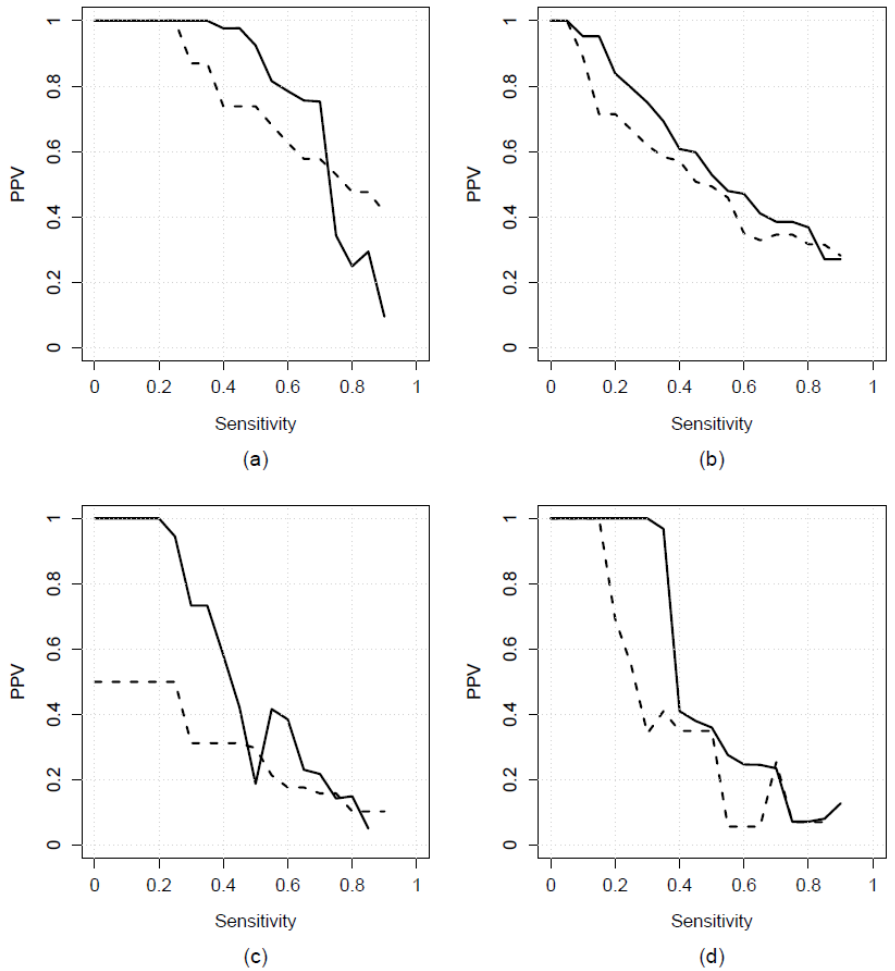
Figure 3. Validation positive predictive value (PPV) at various sensitivity thresholds for the optimal state-wide (solid) and metropolitan (dashed) models for: ( a ) high risk foot (HRF), ( b ) chronic obstructive pulmonary disease (COPD), ( c ) heart failure (HF), and ( d ) type II diabetes